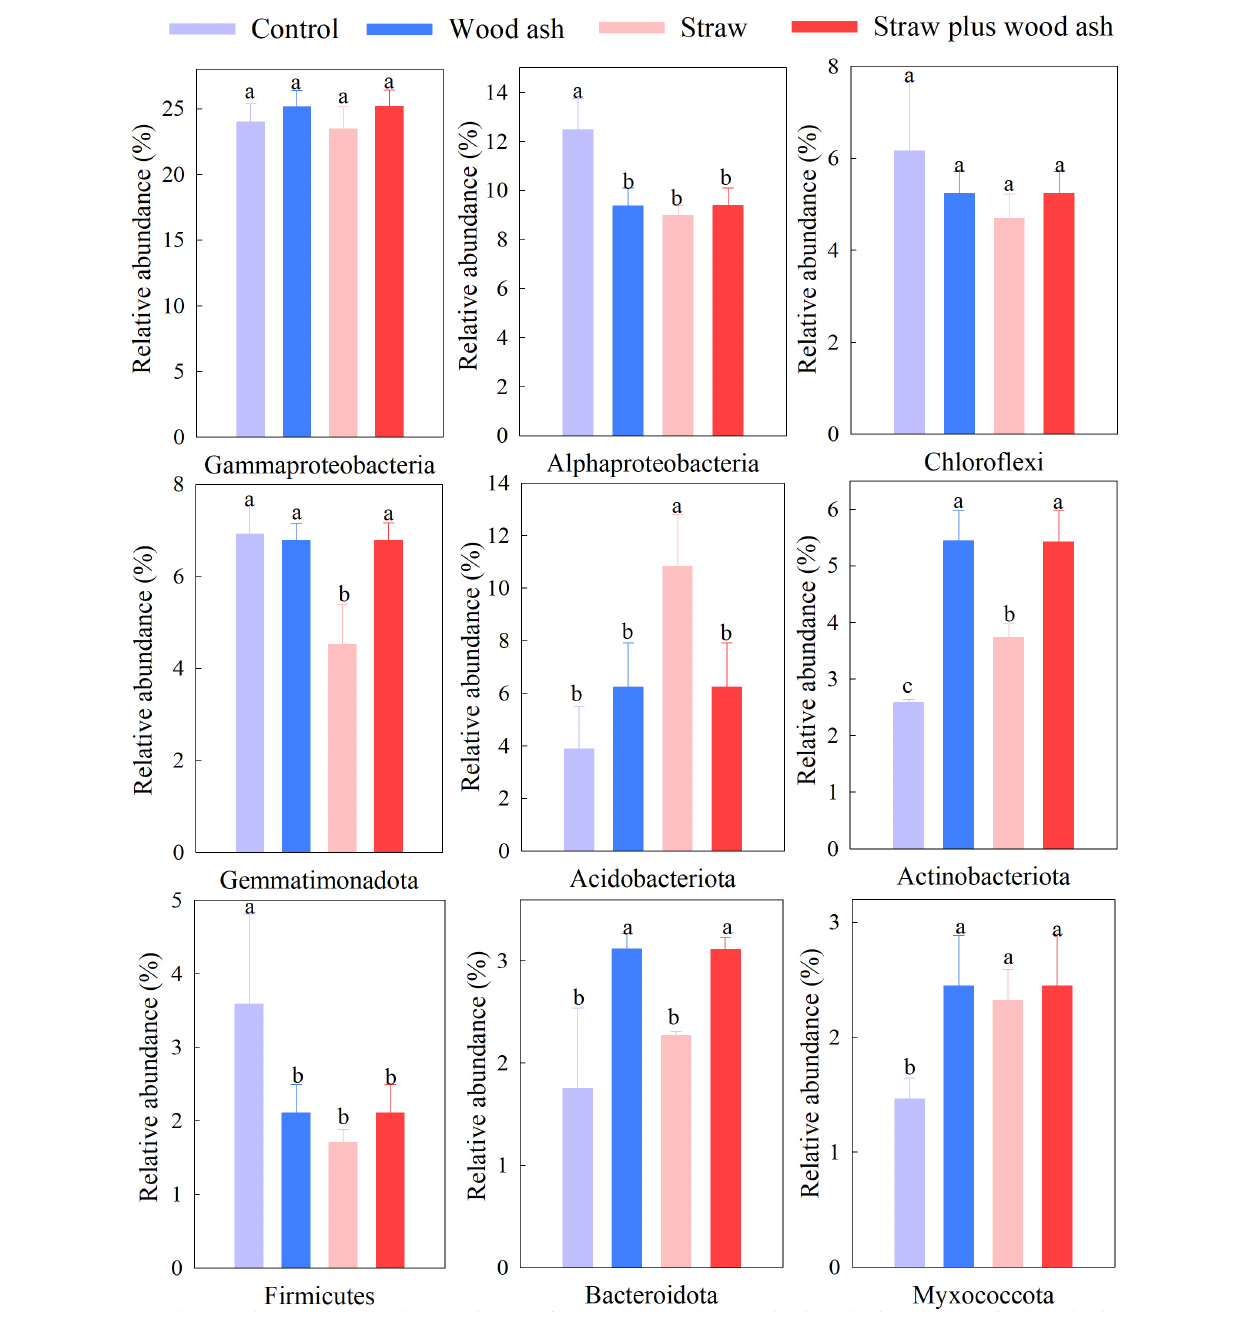
FIGURE 3 | The relative abundance of levels of different phyla in this study. Control, soil alone; W, addition of wood ash; S, addition of wheat straw; SW, addition of wheat straw plus wood ash. Data (means ± SE, n = 3) followed by different letters indicate significant differences among the treatments at p <